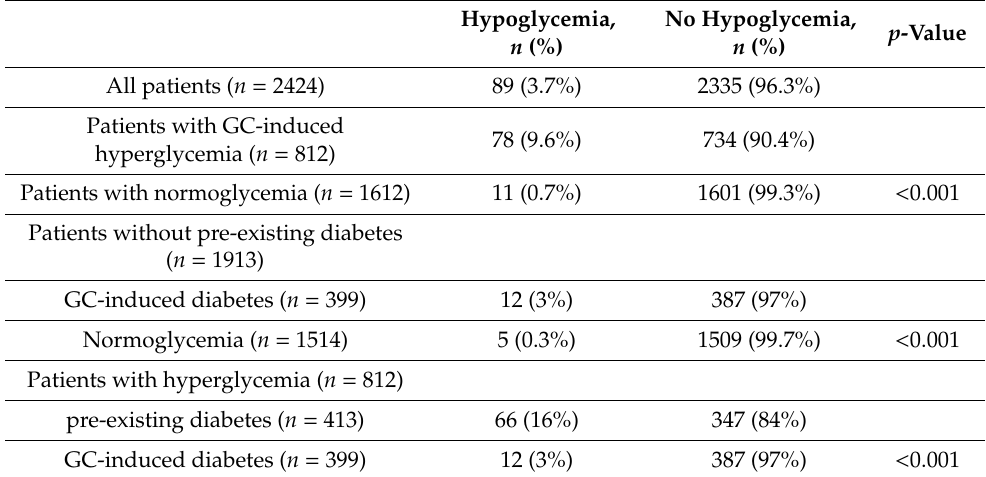
Table 2. Rate of hypoglycemia according to glycemia and diabetes